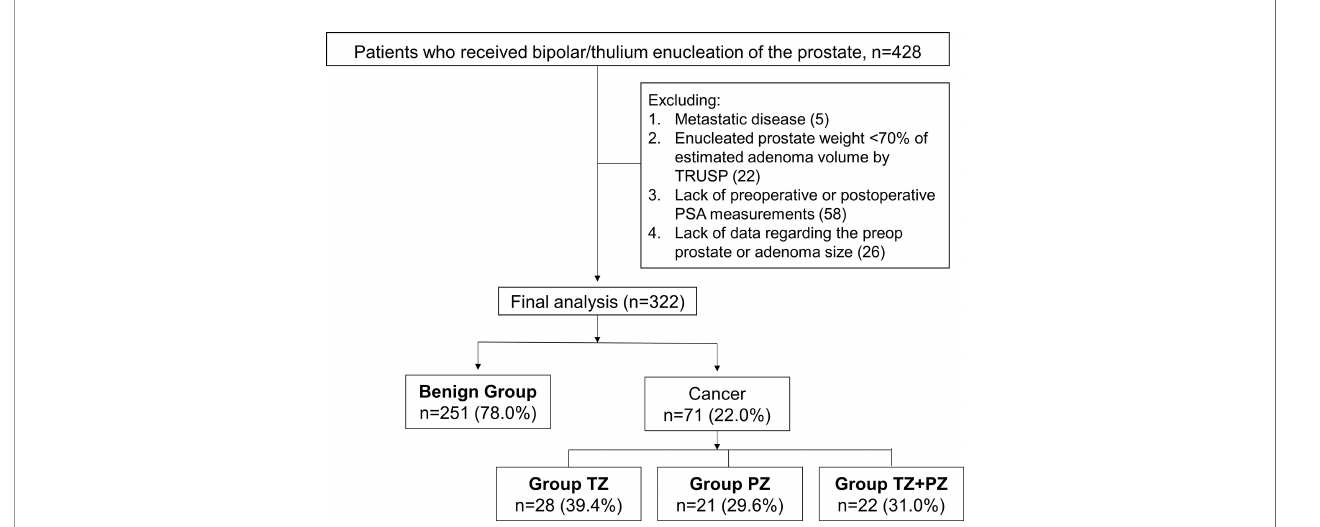
FIGURE 1 | Patient cohort based on the surgical pathology for men who underwent transurethral prostate enucleation. Preop, preoperative; postop, postoperative; PSA, prostate-speci fi c antigen; PZ, peripheral zone; TRUSP, transrectal ultrasound of the prostate; TZ, transition zone Some men were excluded because of the presence of more than one exclusion